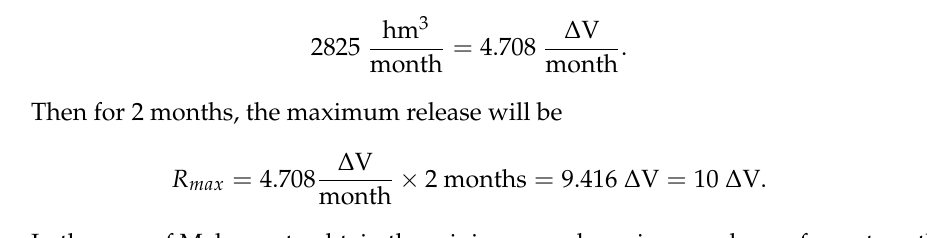
Table 1. Stages, minimum and maximum releases.